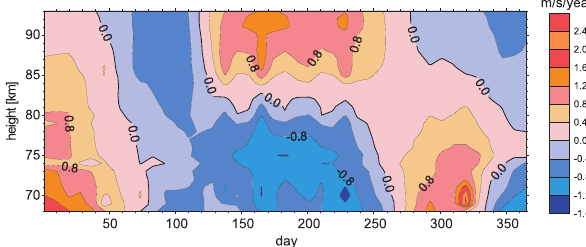
Fig. 12. Mean height-time cross section of the trend in the meso- spheric zonal wind at Juliusruh (partial regression coefficient c due to Eq.